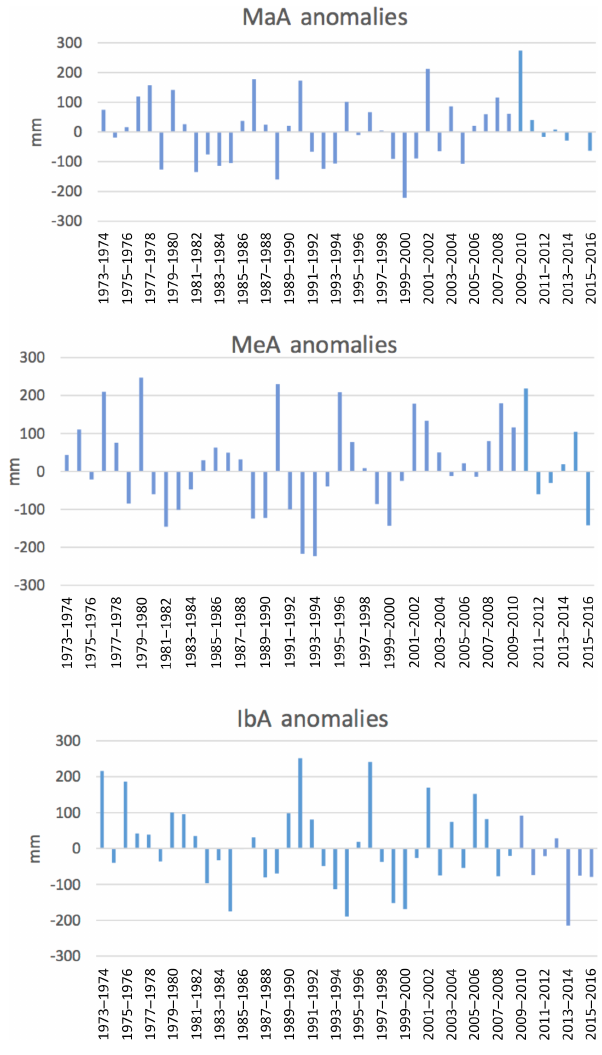
Figure 5. Anomalies of the precipitation for the hydrological year at the airports of Mallorca Menorca and Ibiza with respect to the respective averages calculated for the reference period 1980–1981 to